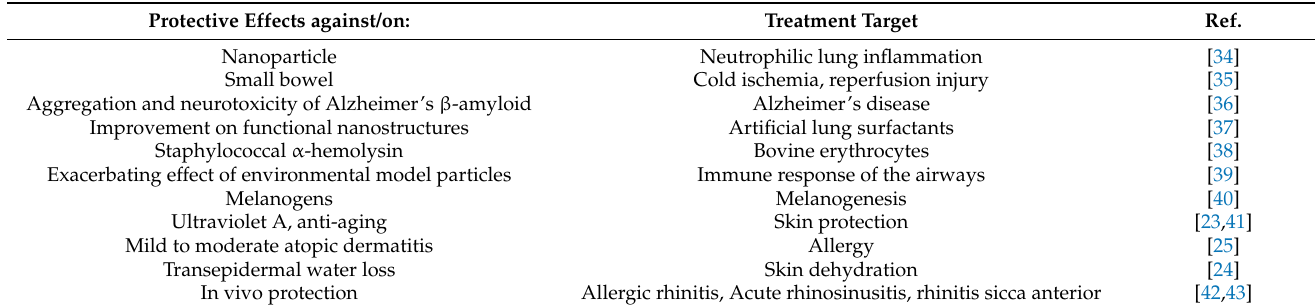
Table 2. Several significant biomedical and skin-protective effects of